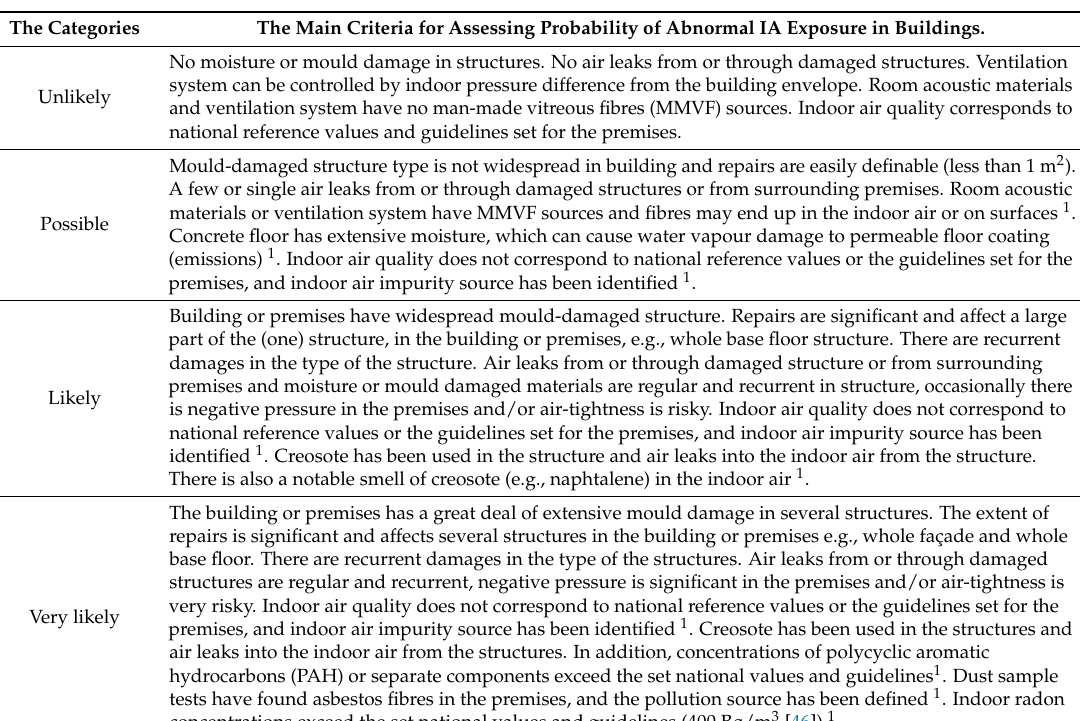
Table 5. Main criteria and categories for assessing probability of abnormal IA exposure in buildings. In cases of moisture and mould damage, air leaks through or from damage to IA must be looked at simultaneously with indoor negative pressure. The predominant IA impurity source is a determining one. National maximum limit values for IA concentrations, microbial growth on building material and MMVF and asbestos in dust are shown in the Table